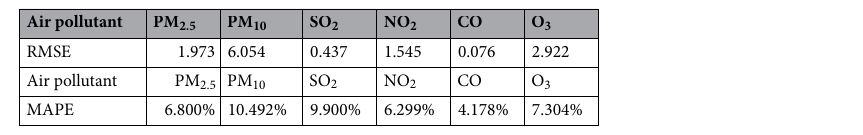
Table 2. Measurement of the prediction accuracy of the proposed model for 6 air